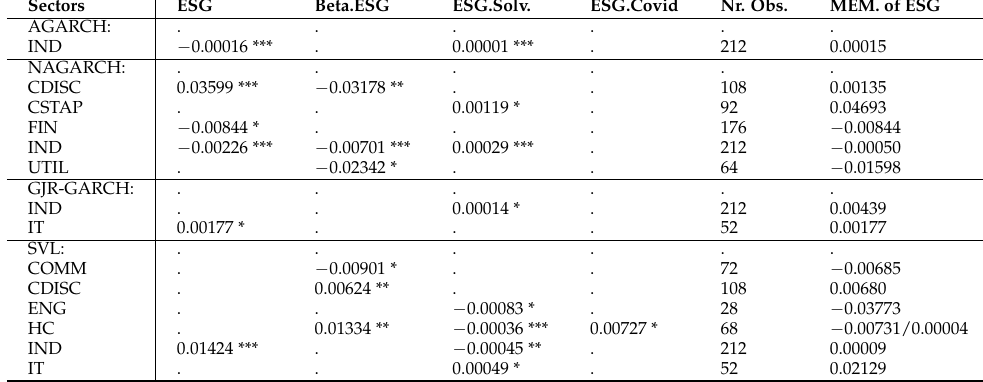
Table A3. LFD-GLS results, by